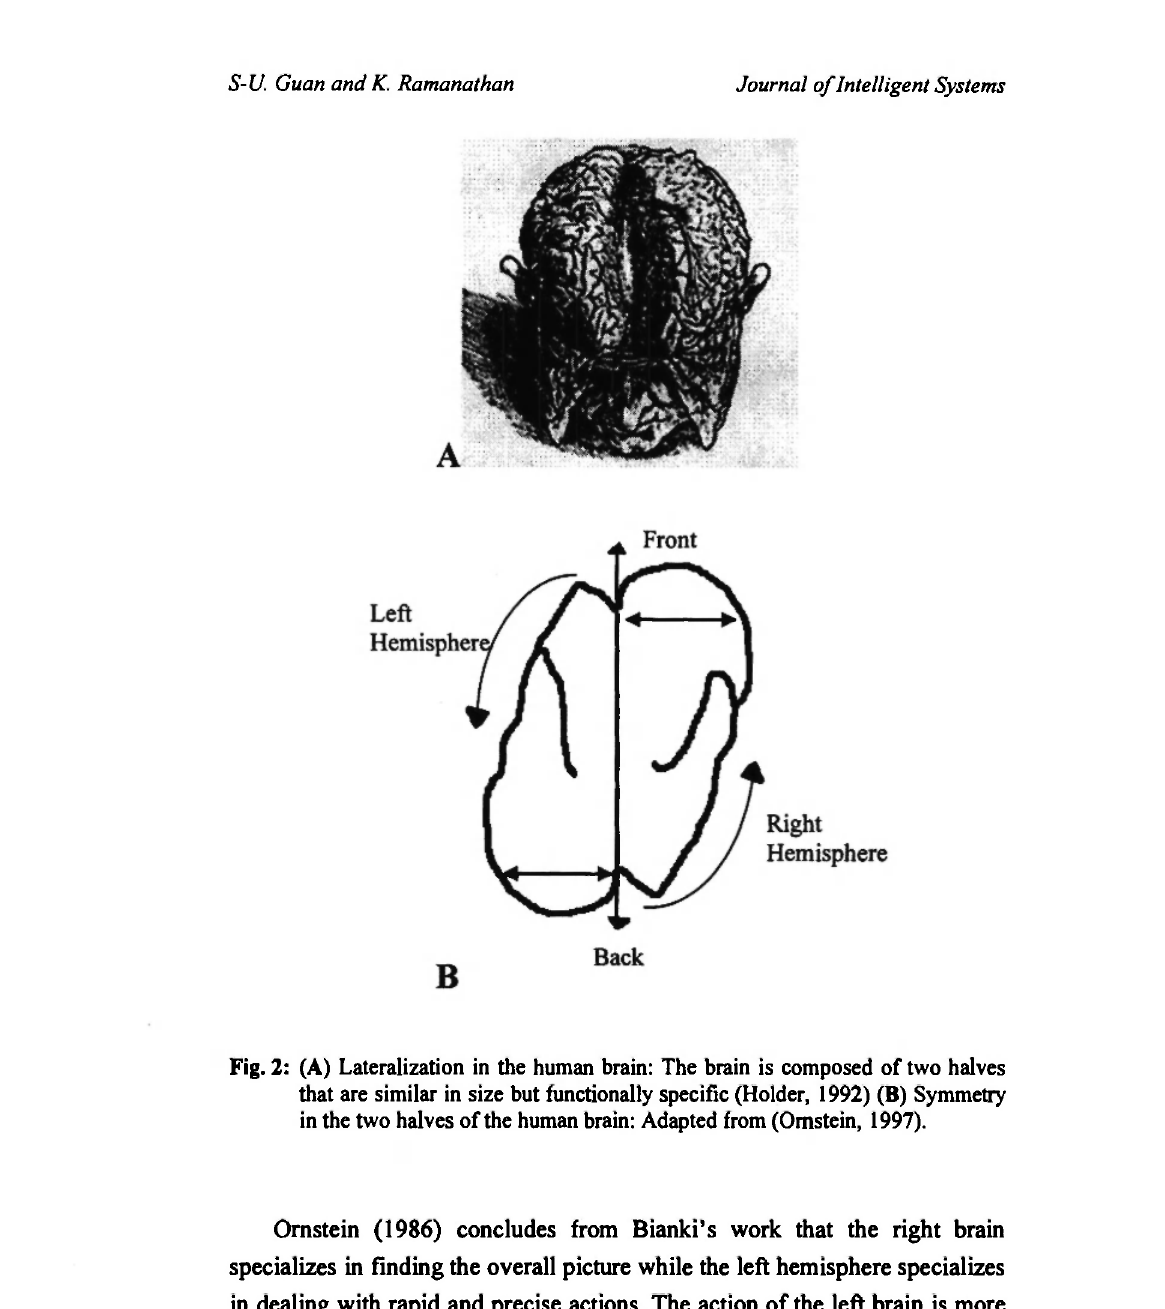
Ornstein (1986) concludes from Bianki's work that the right brain